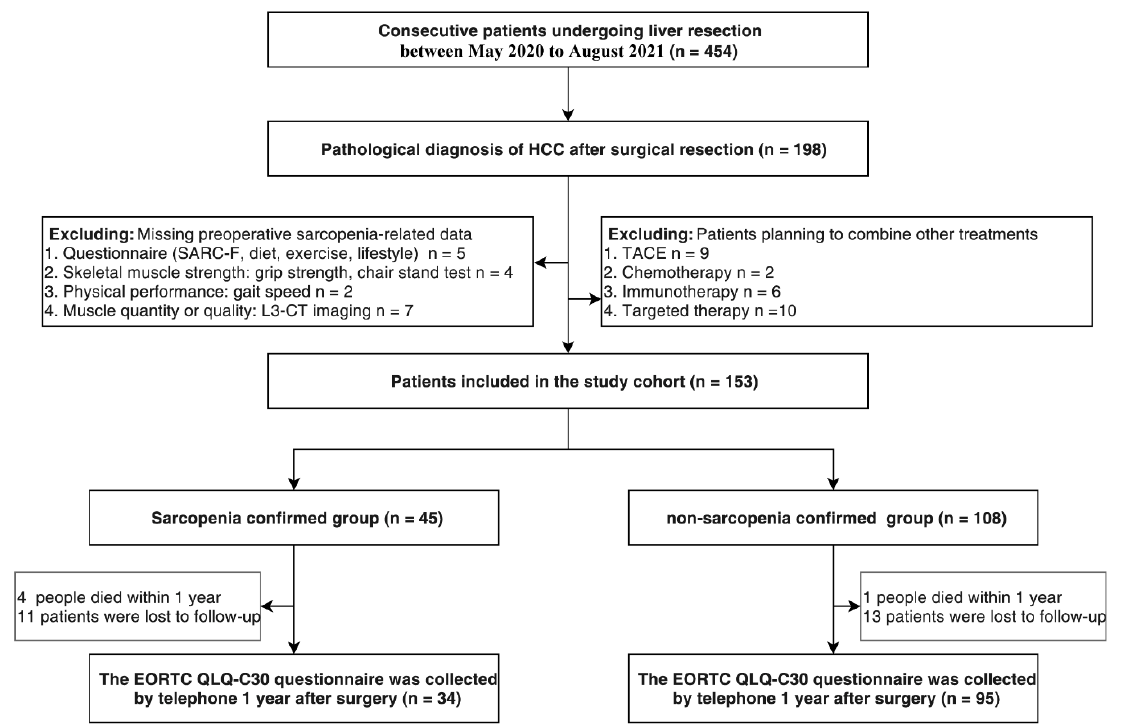
Figure 1. Screening of patients with HCC and sarcopenia study